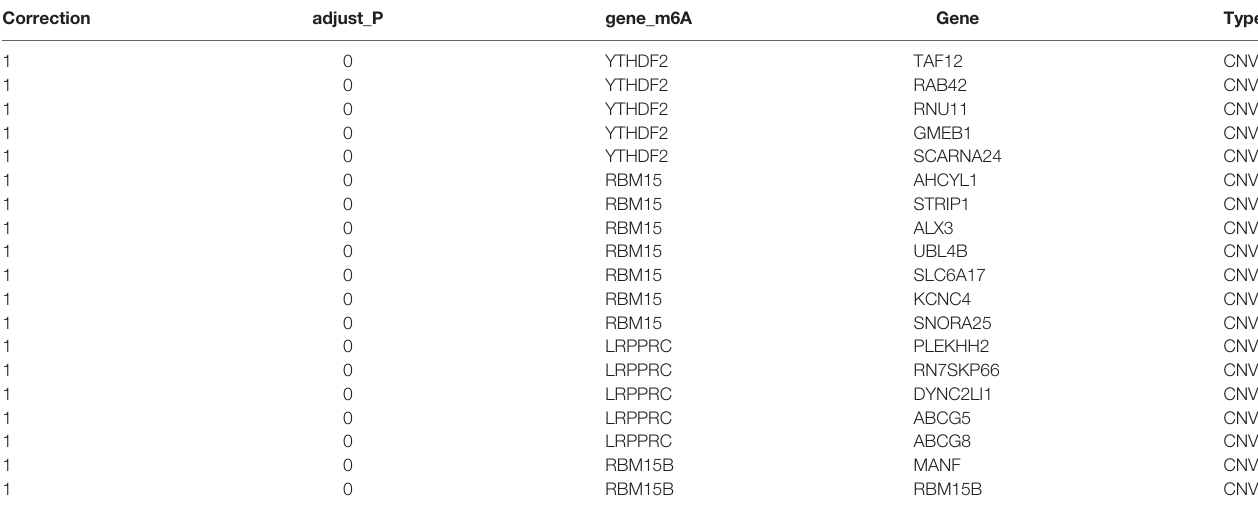
TABLE 2 | Genes were signi fi cantly correlated with m6A regulators at the level of copy number variation (top 20). Correction adjust_P gene_m6A Gene Type